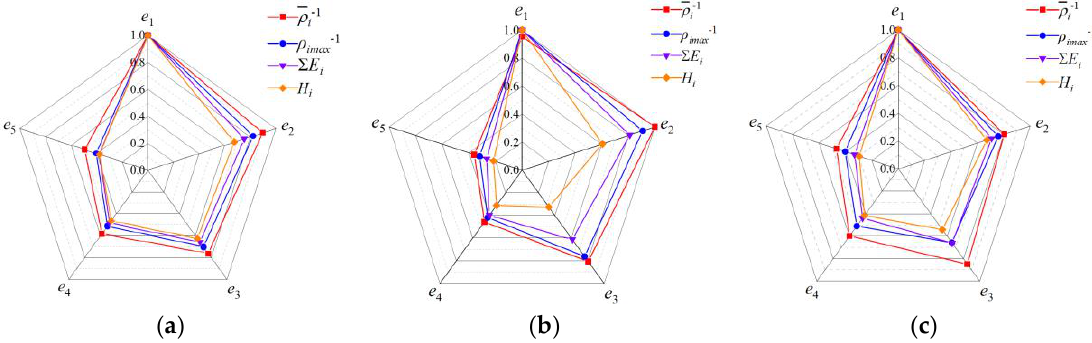
Figure 15. Wear depth and friction wear energy density of three blades of scheme 1 ( y i = 6.700 mm):